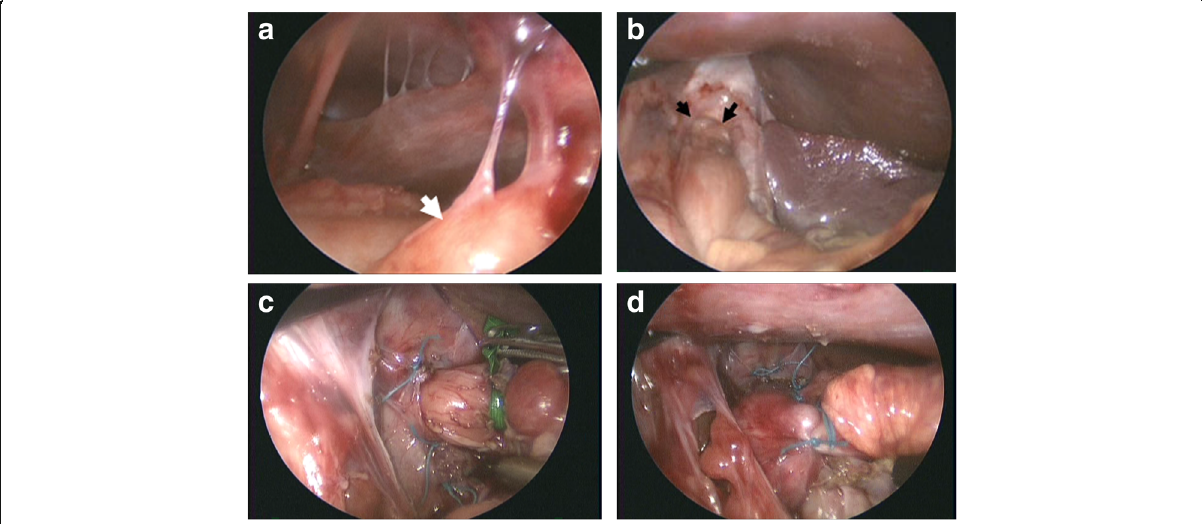
Fig. 3 Intraoperative laparoscopic view of the upper abdominal cavity. a Dozens of fibrous bands and adhesion between the small bowel loop (white arrow) and anterior abdominal wall were recognized in the upper abdomen. b Direct view of the widely opened esophageal hiatus (black arrows) before repair. c Hiatal opening was closed around the esophagus with 3 interrupted 3 – 0 braided polyester sutures. d Short and floppy 360° wrapping was performed with 3 interrupted 3 – 0